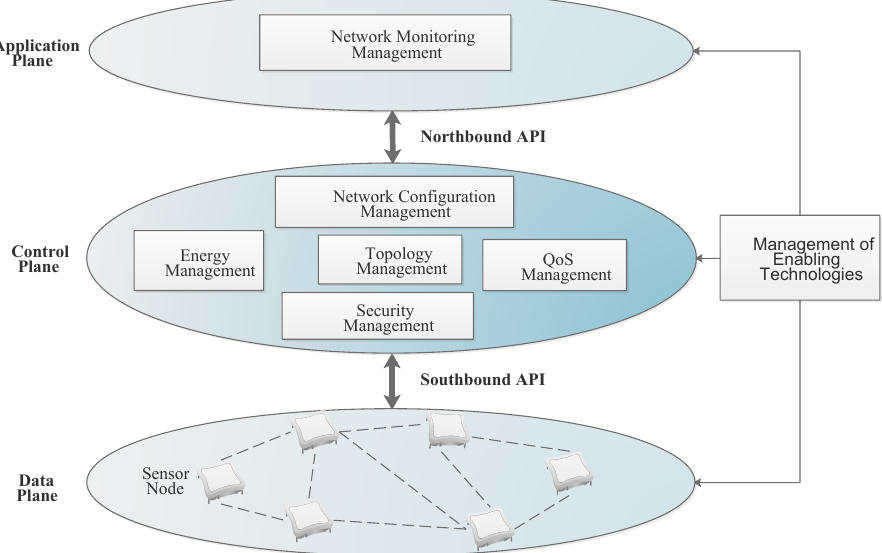
Figure 2. An SDN-based wireless sensor network management architecture, adapted from [28] (Republished with permission of IEEE, from Wireless Software Defined Networking: a Survey and Taxonomy, I. T. Haque and N. Abu-Ghazaleh,18, 2731–2737, 2017